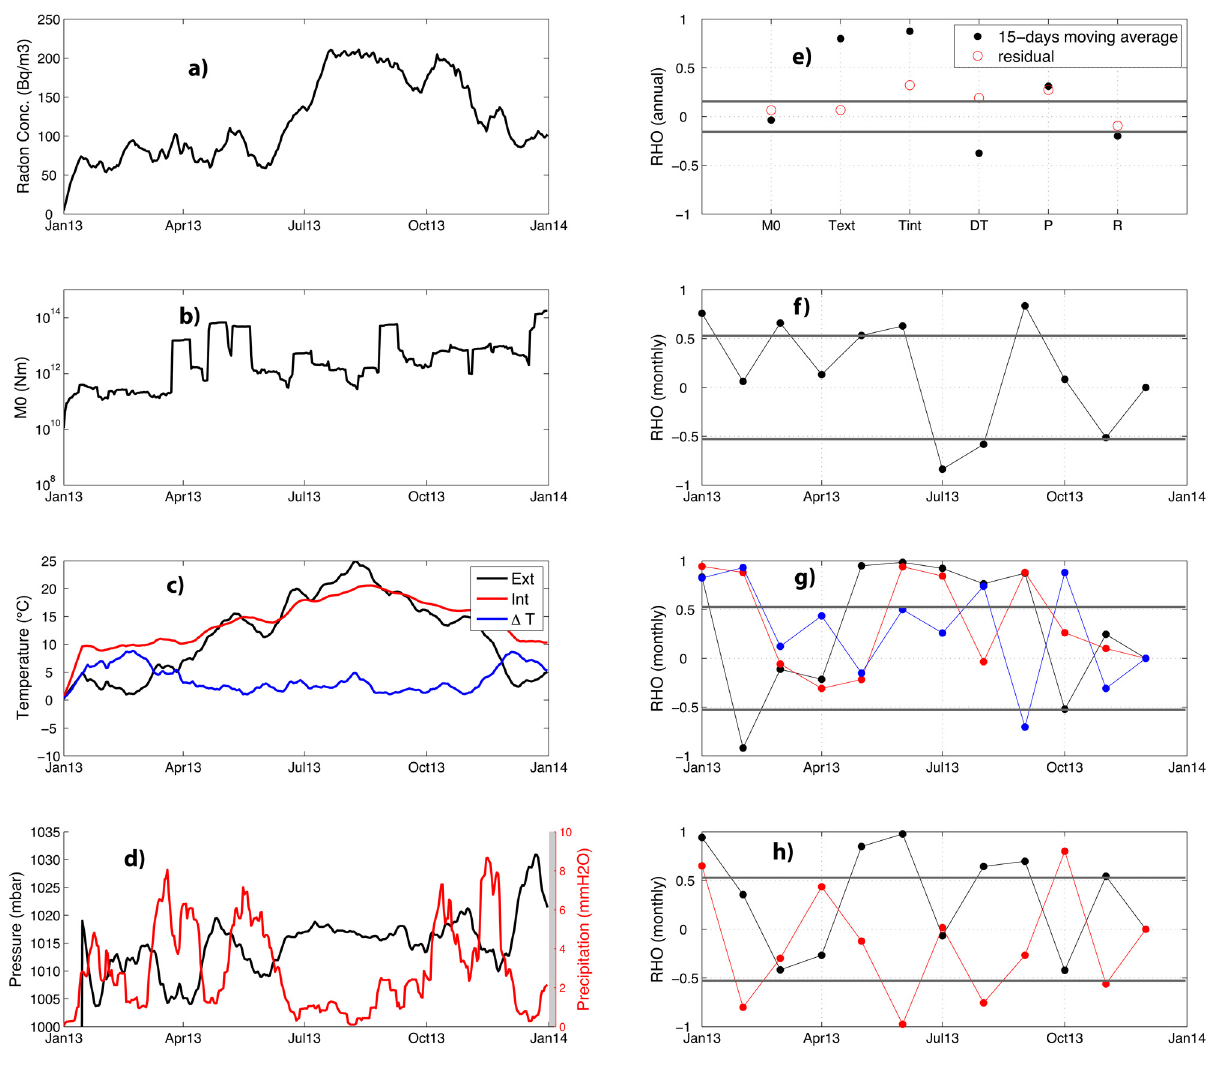
Figure 7. The same as in Figure 5, but between January 1, 2013 and December 31,